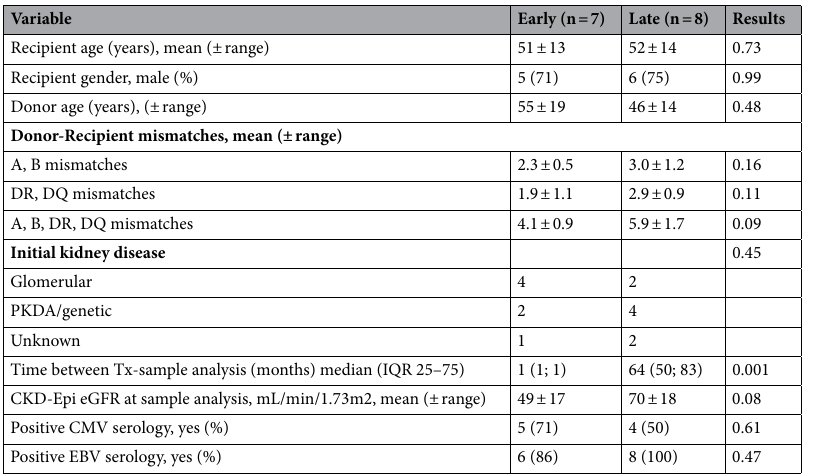
Table 2. Main characteristics of the 15 living-donor kidney transplant recipients included in the functional analysis. eGFR, estimated Glomerular Filtration